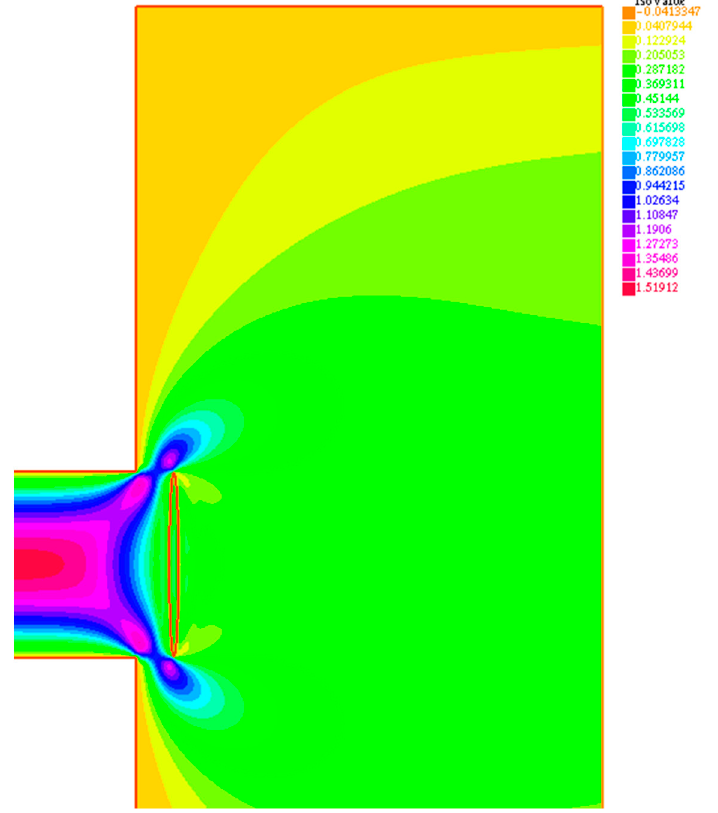
Figure 7. Case b: valve operative condition with h = 10 mm, with velocity horizontal component u .